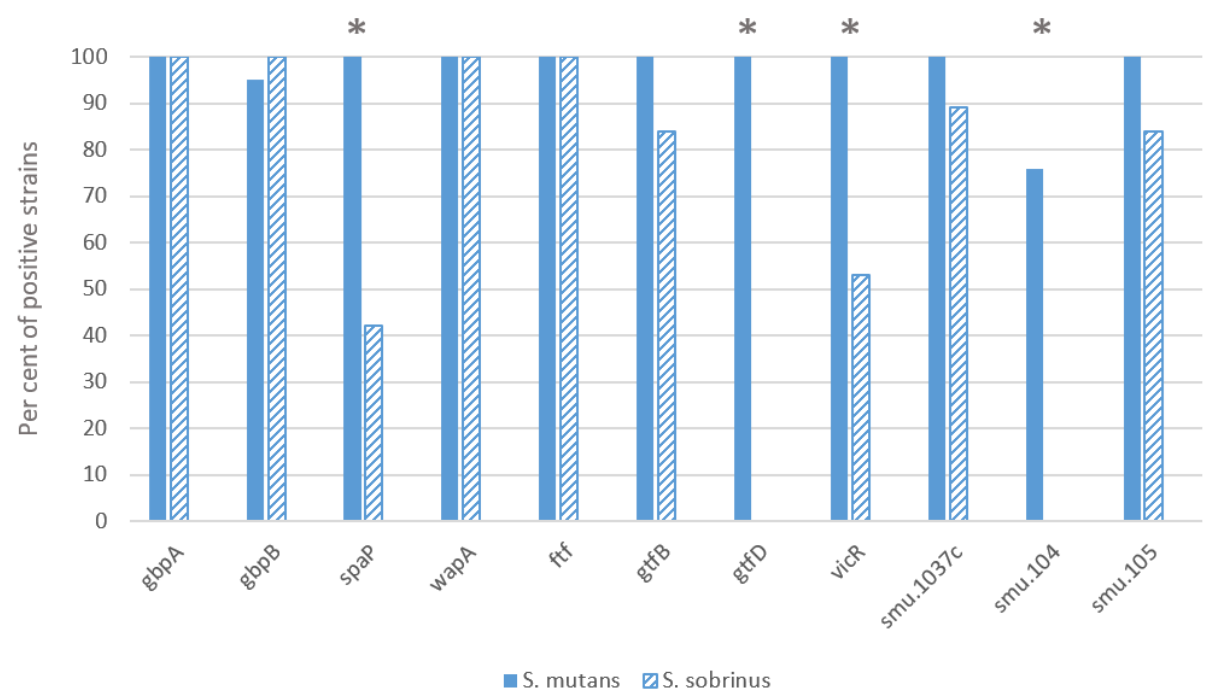
Figure 1. Distribution of virulence genes between two mutans streptococci species. Pearson chi- square test was applied, the asterisk indicates difference p < 0.01. Table 3. Correlation between SM score and virulence genes between mutans streptococci and moth- Tables 3 and 4 show correlations between clinical parameters and virulence genes. ers/children. The level of each person’s SM score (0–3) is compared to the specific gene present/absent in their bacterial strain. Results indicating positive correlation and statistical significance ( p < 0.05) are marked in